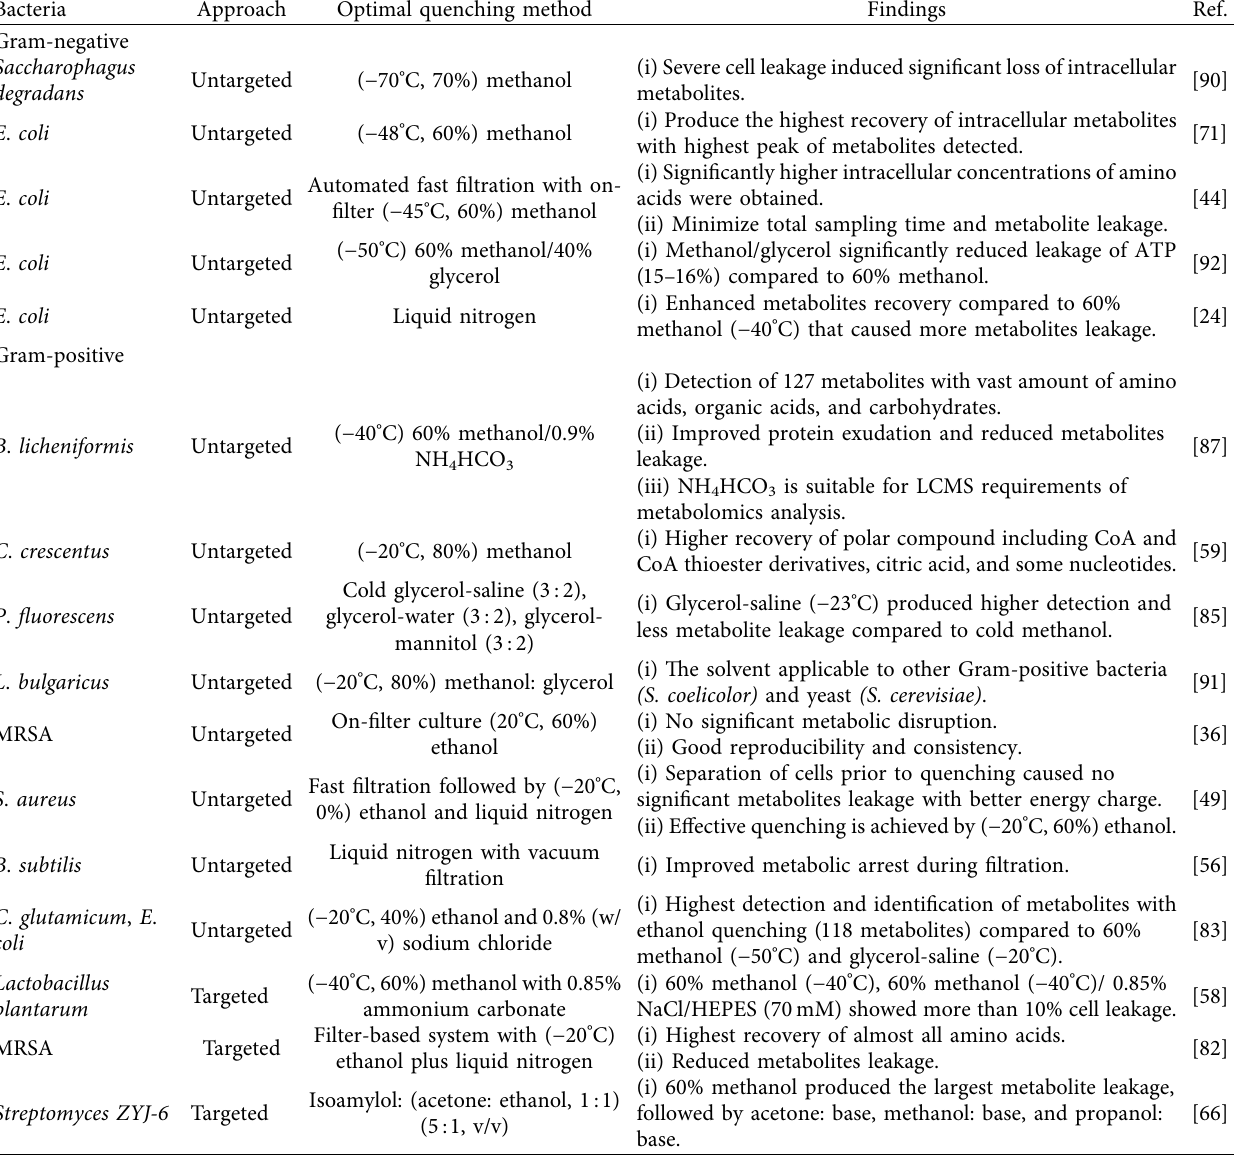
Table 1: Summary of optimized quenching methods in bacterial metabolomics